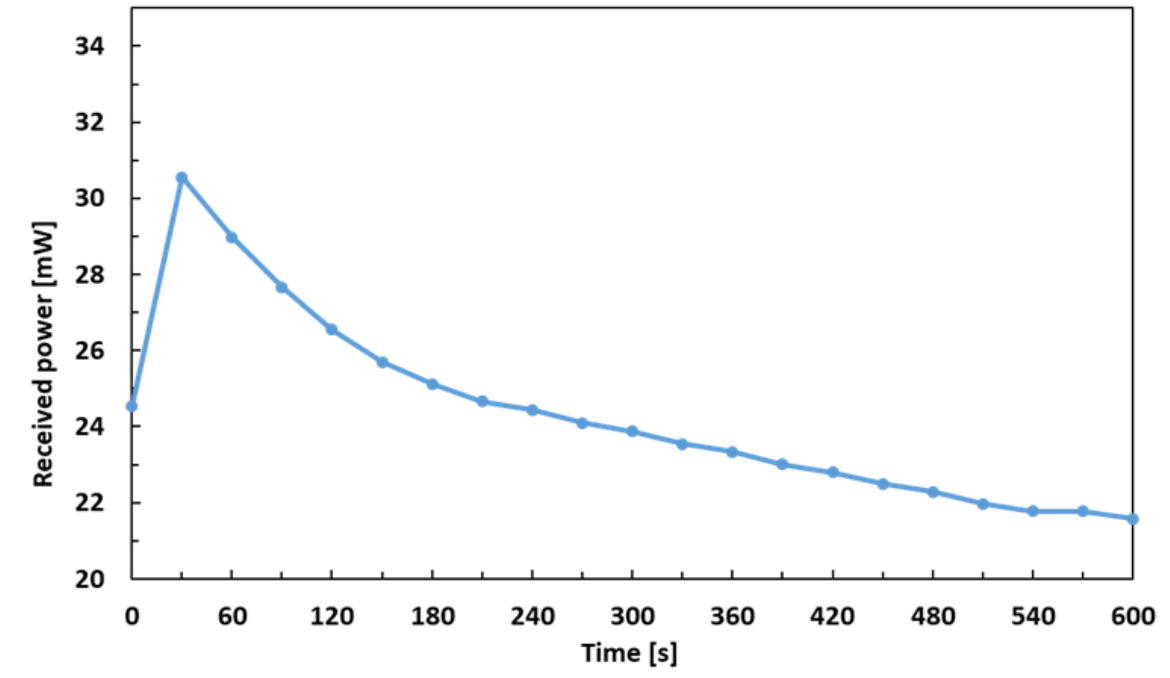
Figure A4. Received power vs. time for 80 W MWA in SP.